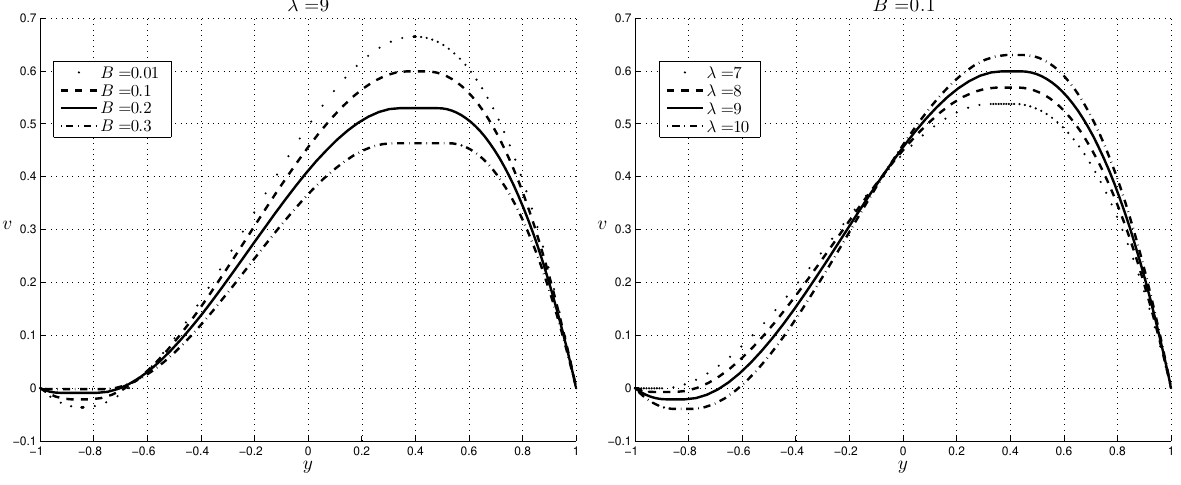
Figure 10. Case 3 : profile of the